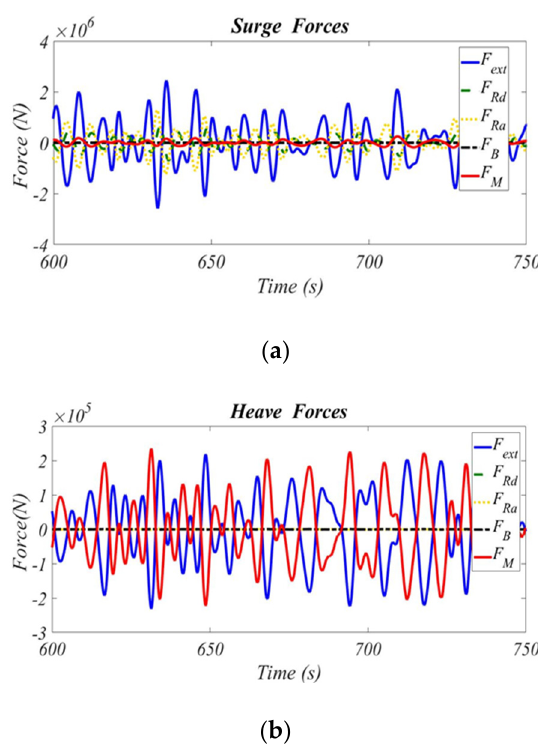
Figure 20. Time histories of wave-load components at ( a ) the surge natural frequency ( f p = 0.037 Hz), and ( b ) the heave natural frequency ( f p = 0.015 Hz) for the MIT/NREL TLP.